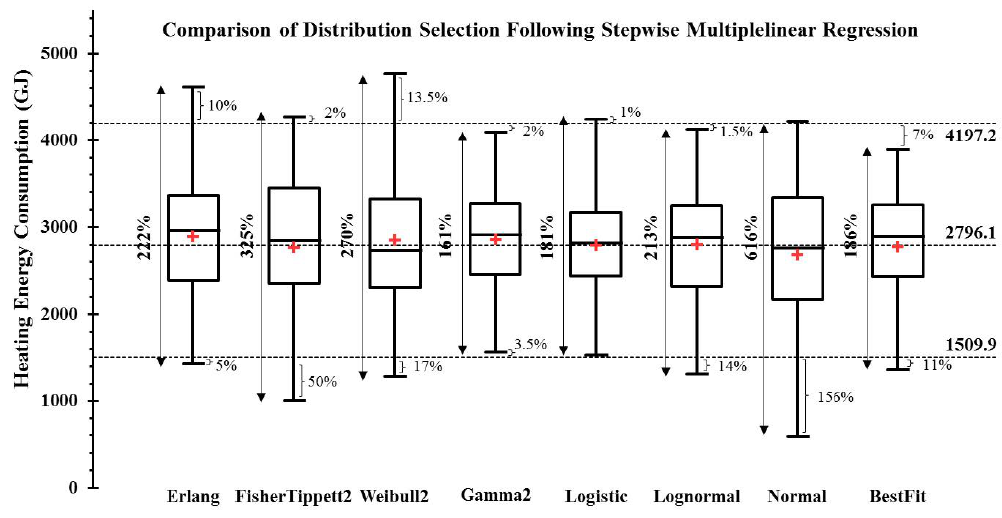
Figure 7. Heating energy use probability density functions when following a stepwise multiple linear regression model and comparing selection of various input average annual weather variables distributions used in the uncertainty propagation method.